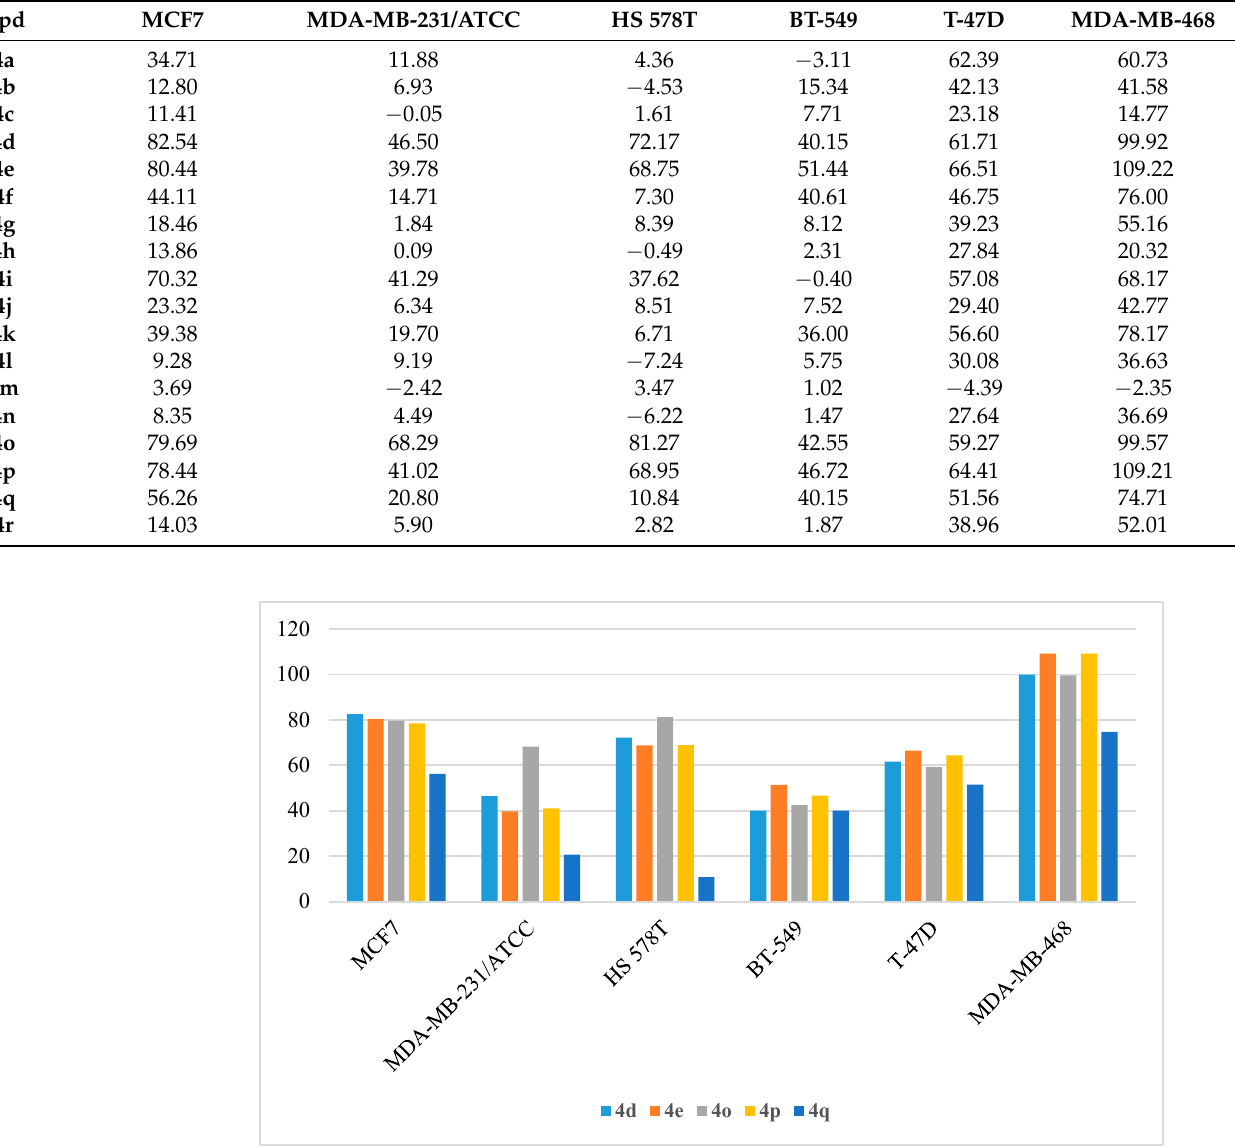
Figure 13. Anti-proliferative activities (% GI) of compounds 4d , 4e , 4o , 4p , and 4q against breast cancer cell lines.